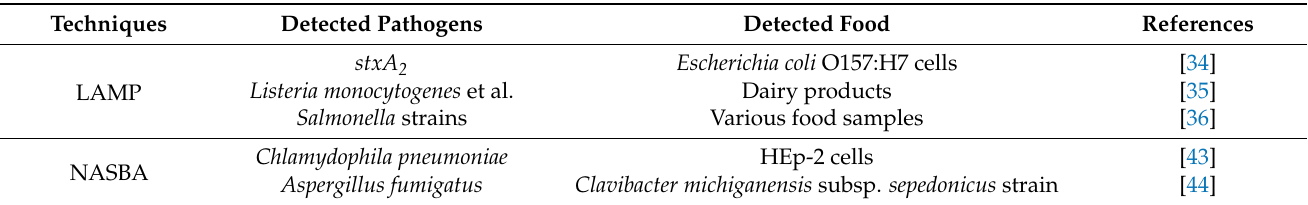
Table 2. Application of loop-mediated isothermal amplification in the detection of foodborne pathogens.